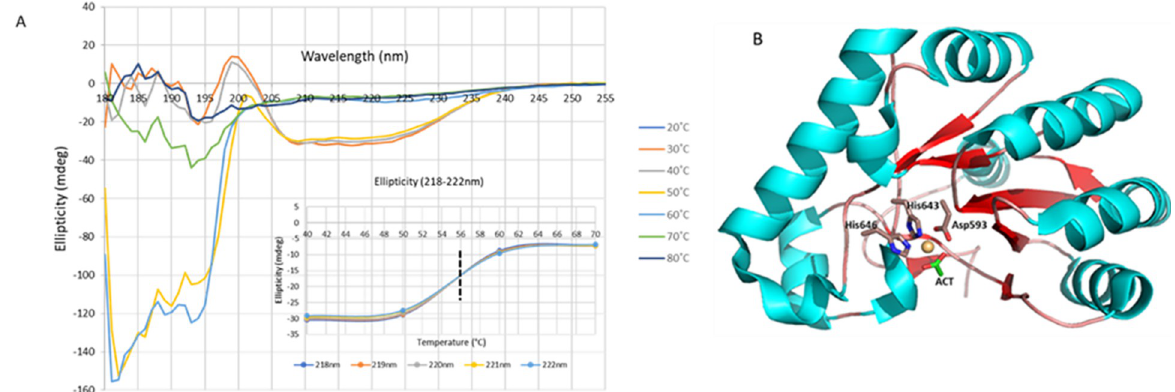
Fig 3. Characterization of Xyl-CE4. A) Far-UV circular dichroism spectrum of Xyl-CE4 domain. The CD signature and thermal scan for Xyl- CE4 at temperatures between 20 and 80˚C. Ellipticity at increasing temperature (insert) identifies a melting point of 56˚C. B) The crystal structure of Xyl-CE4 showing α -helices (cyan), β -strands (red), Co 2+ (brown) and acetate (green). The residues coordinating the metal ion are shown as sticks.